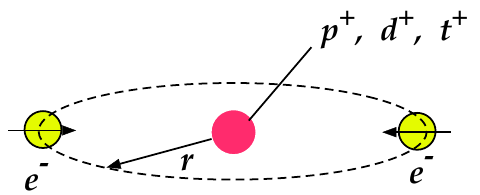
Fig. 1. The “classical” tresino electromagnetic configuration. Note that tresinos are quantum objects so the distance, on average, be- tween the electrons (in yellow) is about 15Comptons ( λ c